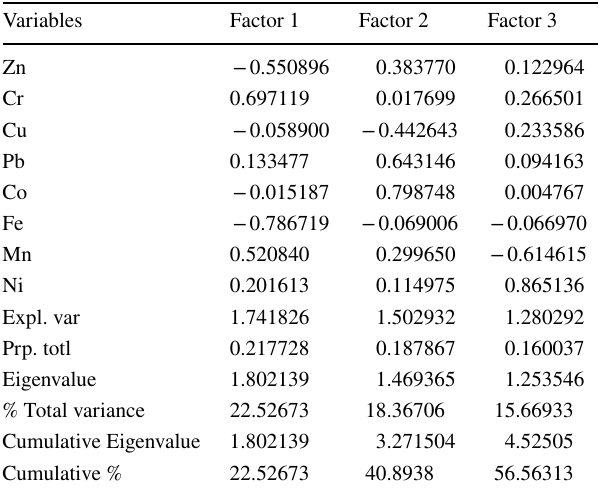
Table 7 Factor analysis for the tertiary formation groundwater sam- ples (varimax rotated)